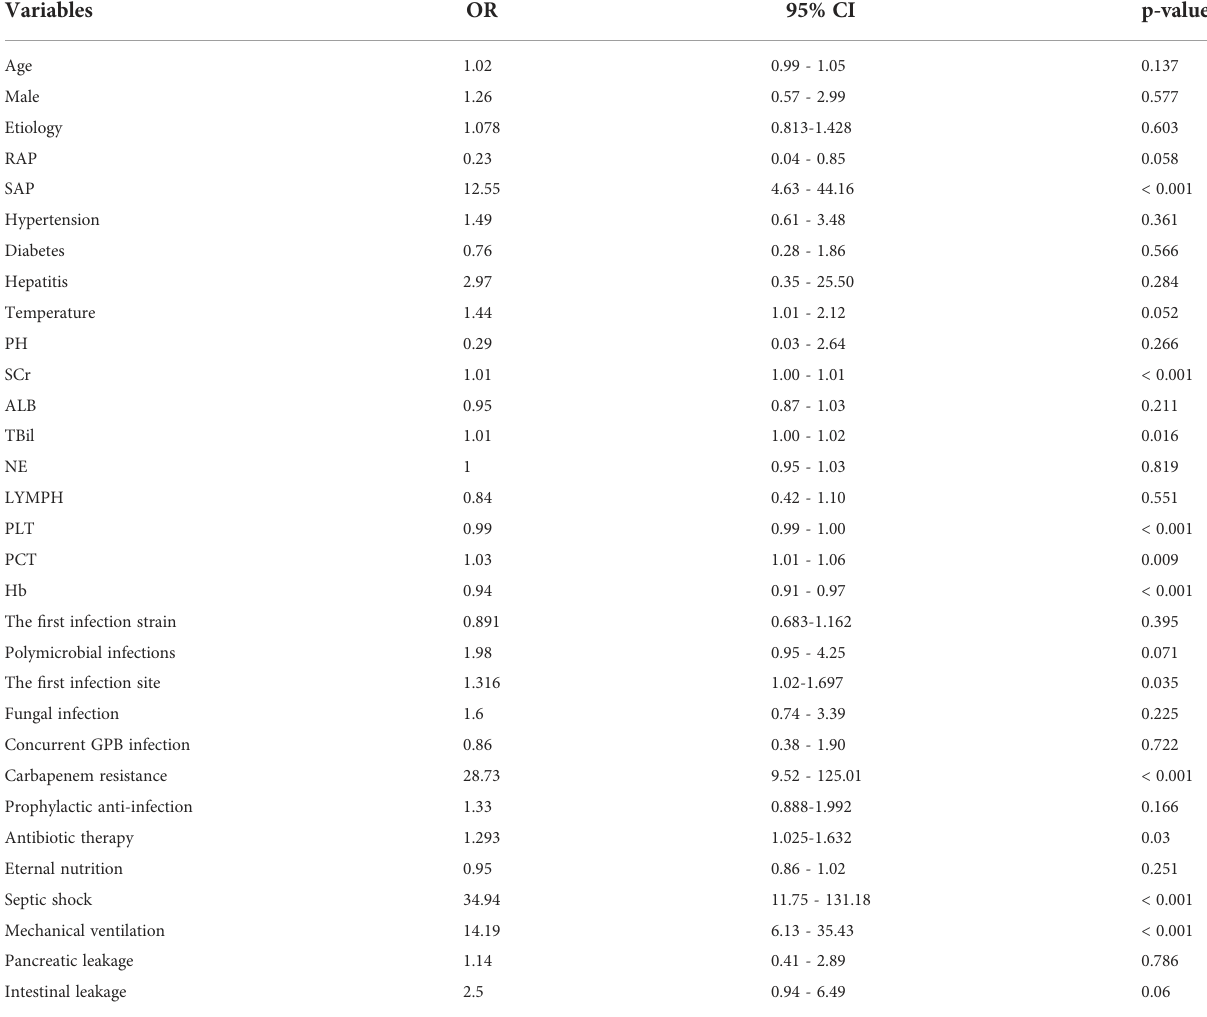
TABLE 2 Univariate logistic regression analysis based on baseline characteristics in the survival group and death